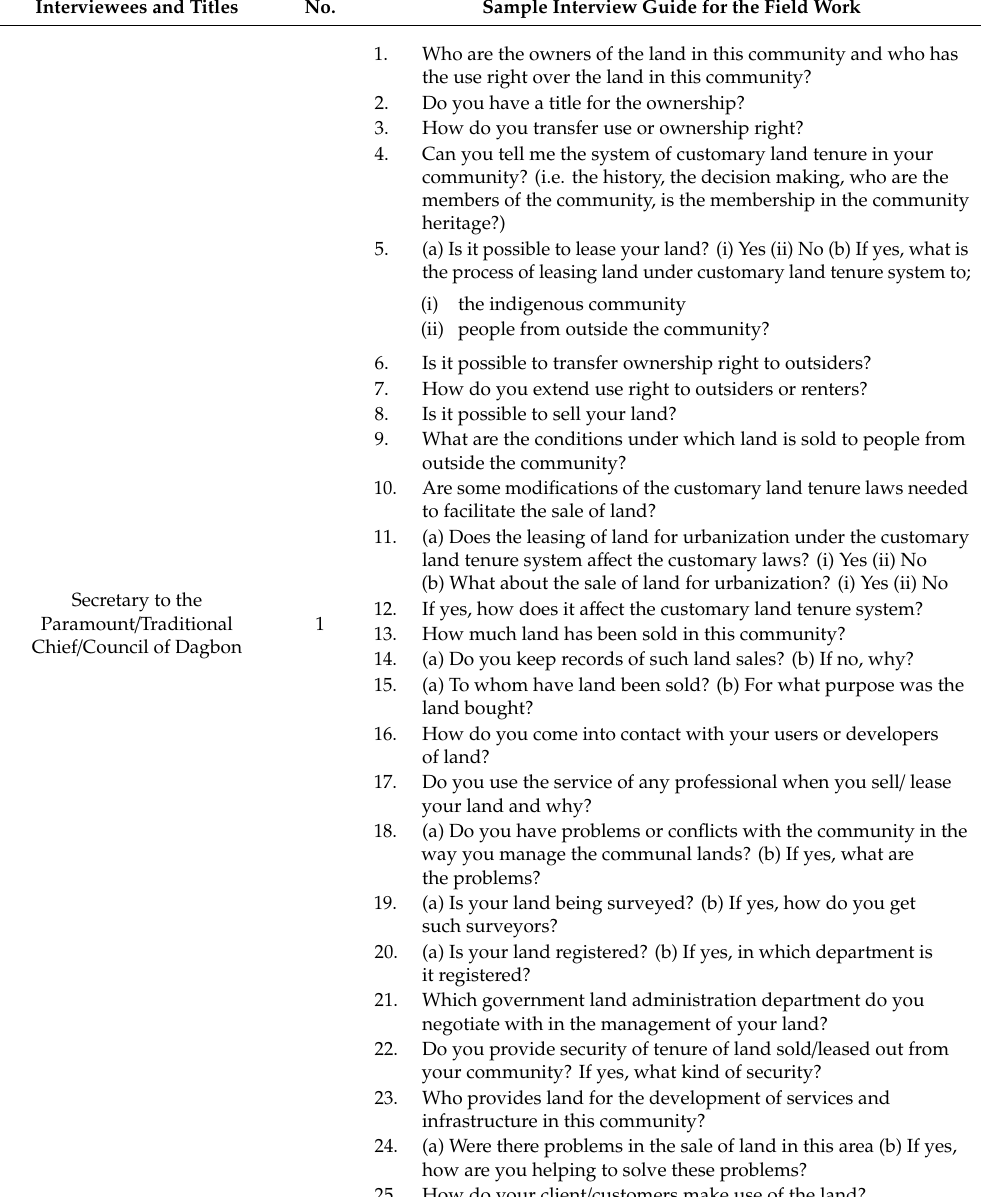
Table A1. Fieldwork planning guide and